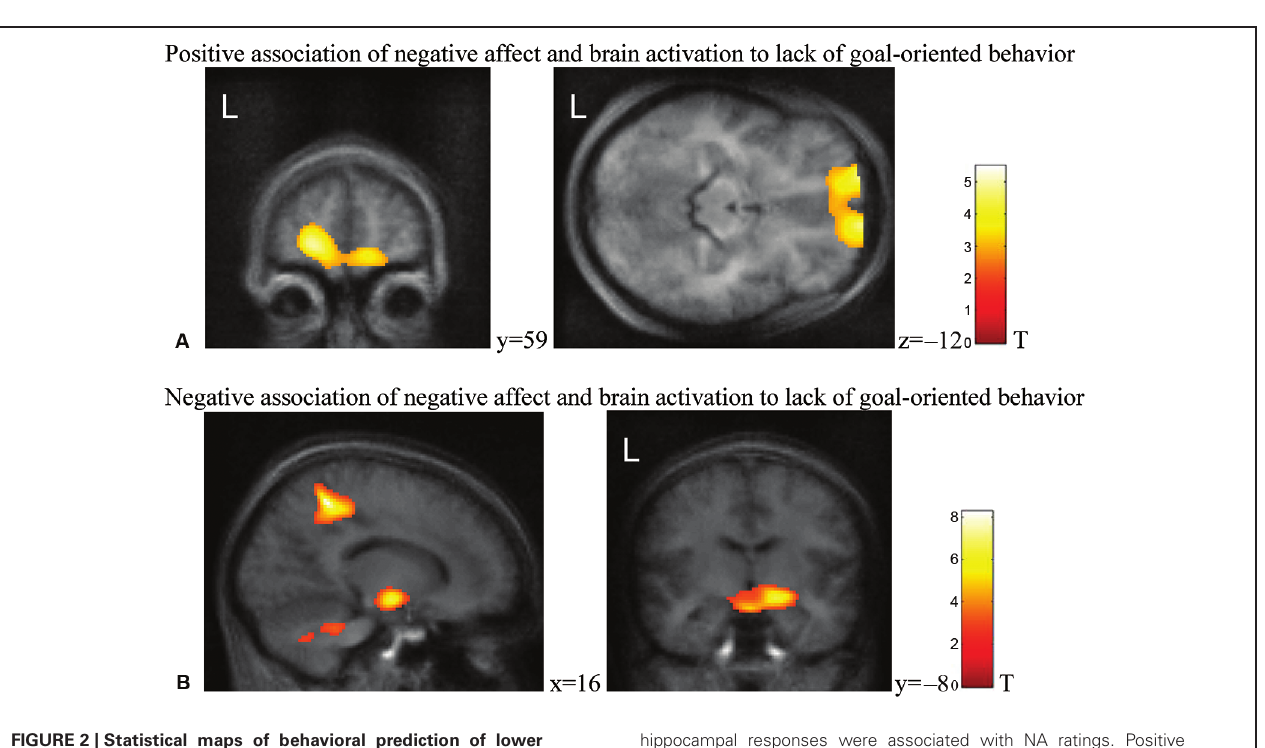
FIGURE 2 | Statistical maps of behavioral prediction of lower individual responsiveness to lack of goal-oriented behavior (threshold for cluster size according to p < 0.05 corrected) . (A) Ventromedial prefrontal as well as (B) left precuneus and left